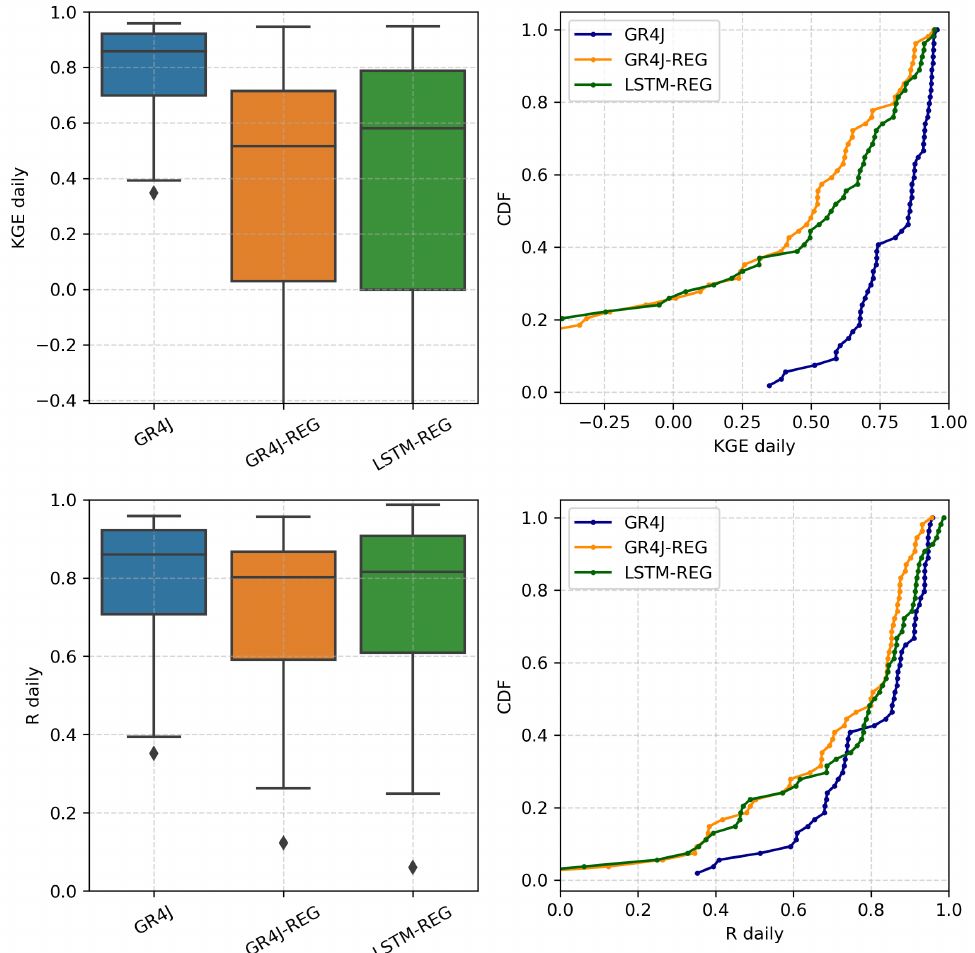
Figure 8. Performance evaluation results of GR4J-REG and LSTM-REG gridded runoff datasets in comparison with the results of GR4J basin-scale calibration in terms of the Kling–Gupta efficiency (KGE, top row ) and Pearson’s coefficient of correlation (R, bottom row ). The results are presented in the form of box plots ( left column ) and cumulative density functions (CDF, right column